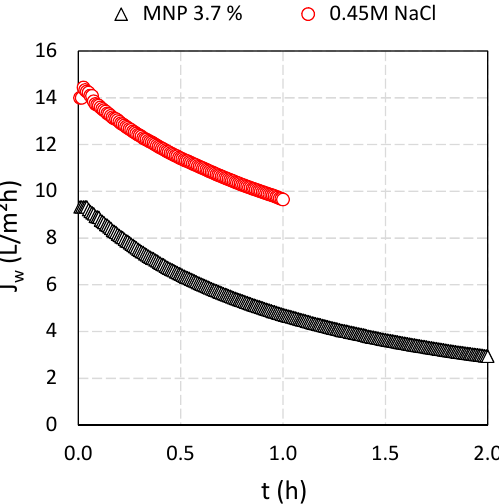
Figure 8. Water fluxes versus filtration time. Higher initial flux was reached using 0.45 M NaCl solution (14.1 LMH) when compared to Fe 3 O 4 @CA (9.3 LMH), respectively.